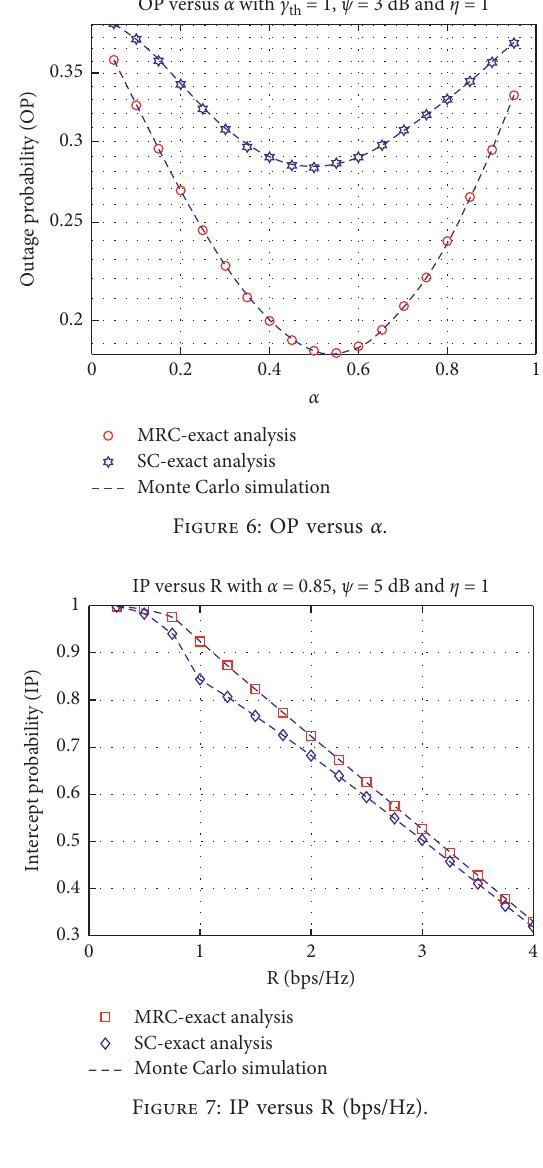
Figure 7: IP versus R